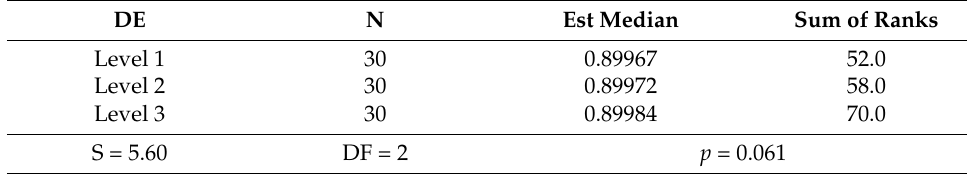
Table 13. Friedman’s test, summer—SSO blocked by DE.